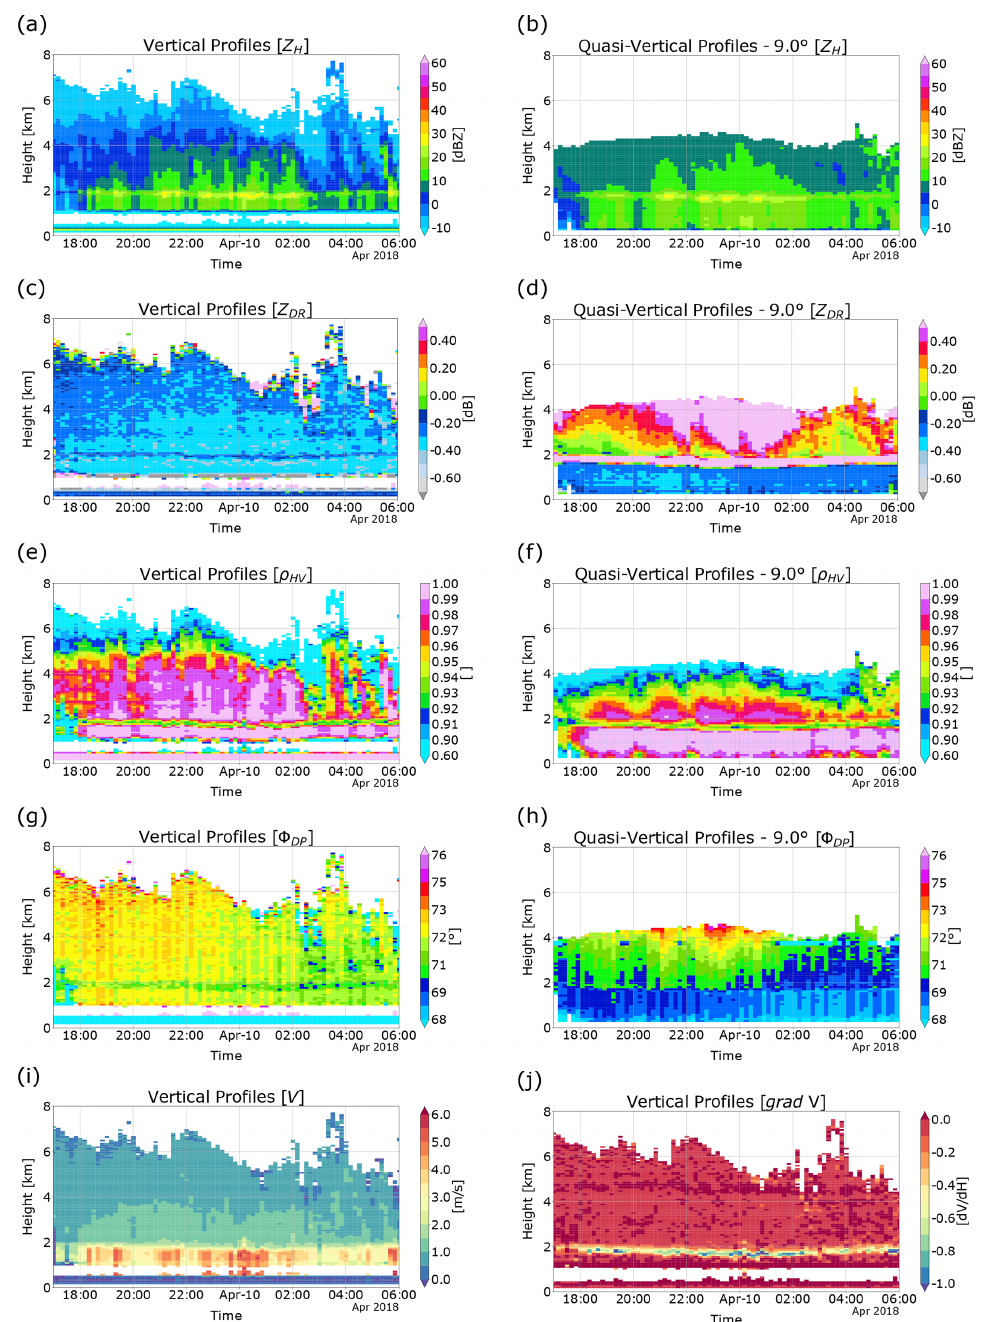
Figure 2. Height versus time plots of Z H (a–b) , Z DR (c–d) , ρ HV (e–f) and (cid:56) DP (g–h) , generated from VPs (left) and QVPs (right) for a pre- cipitation event recorded by a weather radar located at Chenies, UK. Also, panel (i) portrays the radial (vertical) velocity V of hydrometeors, whilst panel (j) shows a plot of the profiles based on the gradient of V measurements [ d V/ d H ]